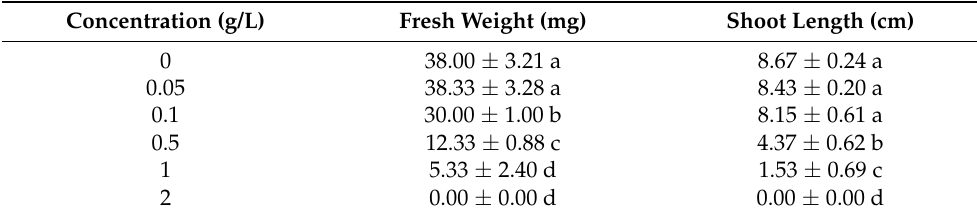
Table 2. The effects of dihydrocoumarin on barnyardgrass seedling growth.